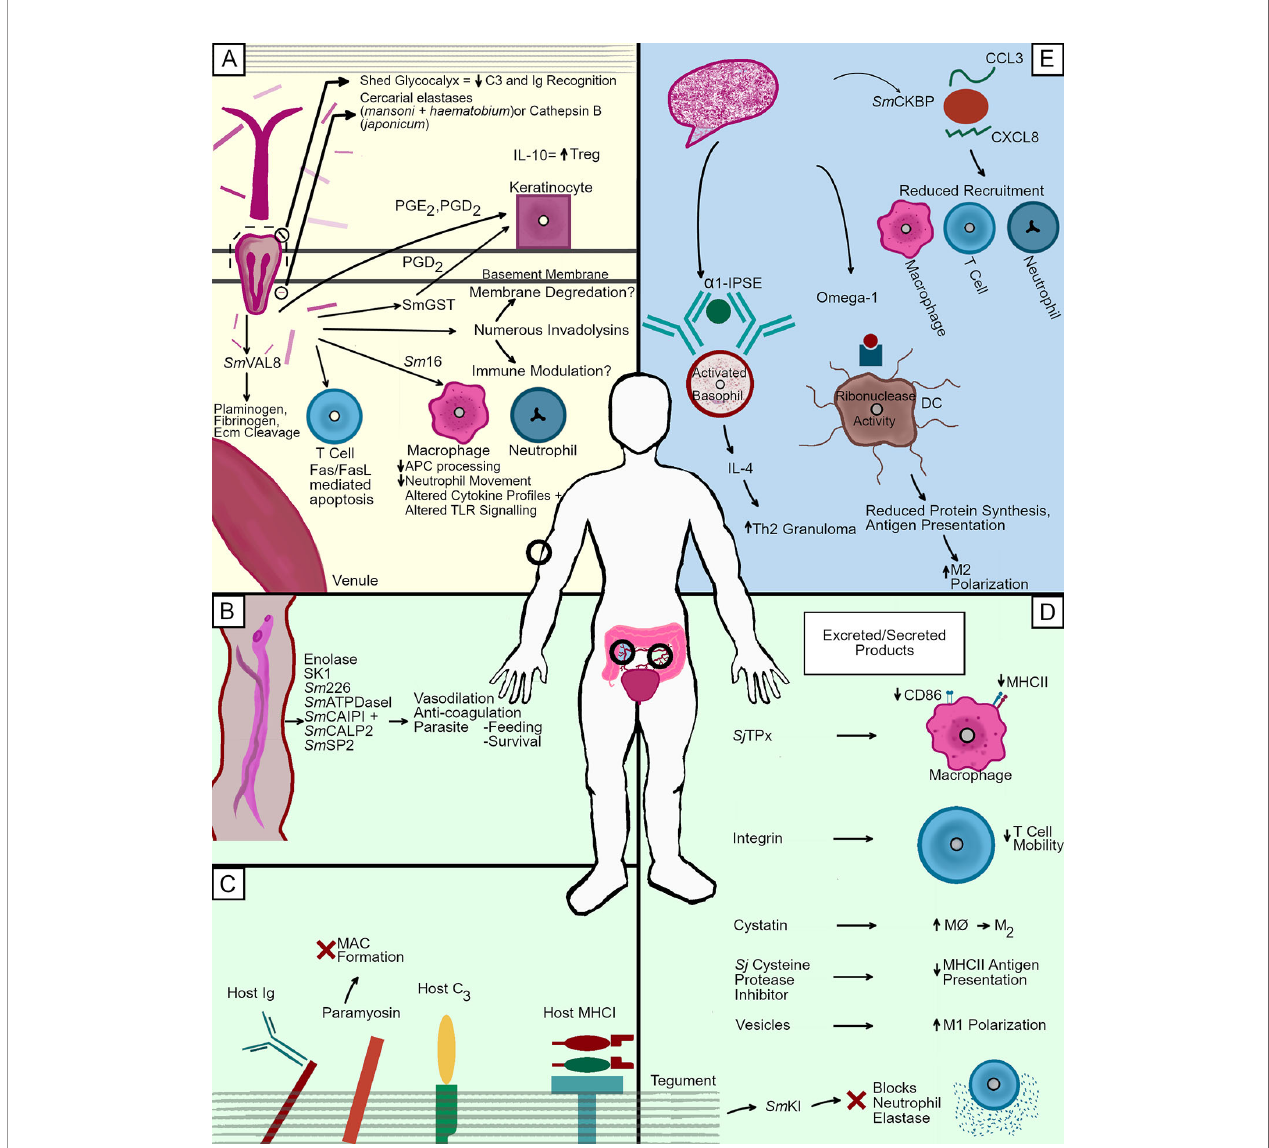
FIGURE 2 | Immunosuppression tactics in the human host. Schistosomes travelling through employ different immune evasion methodologies depending upon their location and life cycle stage. (A) As cercariae penetrate the skin, numerous proteases of different families help facilitate the cleavage of host molecules. The degradation of key structural components such as numerous collagens and elastin by these proteases helps the parasite descend through the epidermis, penetrate through the basement membrane, and eventually navigate the dermis in the search for a nearby venule. The invading larvae also release numerous immunosuppressants such as Sm16 and prostaglandins which alter leukocyte function in an attempt to avoid cell mediated death by creating a favorable immune environment. (B) Adults can also release molecules to reduce blood clotting in the area immediately surrounding a mated pair. This wide variety of molecules may be involved in the degradation of host plasma components to facilitate feeding, but their capacity to act as anti coagulants also implies the creating of a milieu in which the worms are able to move freely without fear of being killed by the coagulation of the blood in which they are emersed. (C) Adult worms in the mesenteric blood vessels incorporate host molecules into their tegument. Many of these molecules are important immune factors, which are bound in such a way as to prevent proper opsonization. IgG is found via its Fc portion, making in unrecognizable to cell found Fc receptors. Complement component C3 is also bound, although the effects of this association are not completely understood. Finally host MHCI can also be found bound to adult worms via its b 2-microglobulin domain. The worm also targets mammalian factors not only for capture, but also for inactivation, as evidenced by schistosome paramyosin inhibiting membrane attack complex formation. (D) Schistosomes release a wide variety of parasite derived factors into their environment to create tolerable conditions for their survival. These molecules perform many different tasks, including the inhibition of cysteine proteases ( Sj cysteine protease inhibitor), the blocking of neutrophil elastase ( Sm KI), and the alteration of antigen processing in macrophages ( Sj Tpx). (E) Schistosome eggs release several factors which is key in skewing the T cell response towards the Th2 phenotype necessary for migration through the intestinal wall. These include a -1, which causes TH2 type granuloma formation through basophil mediated IL-4 production, and W -1, which brings about M2 polarization by altering dendritic cell antigen presentation. The chemokine binding protein Sm CKBP is also present and reduces recruitment of varying